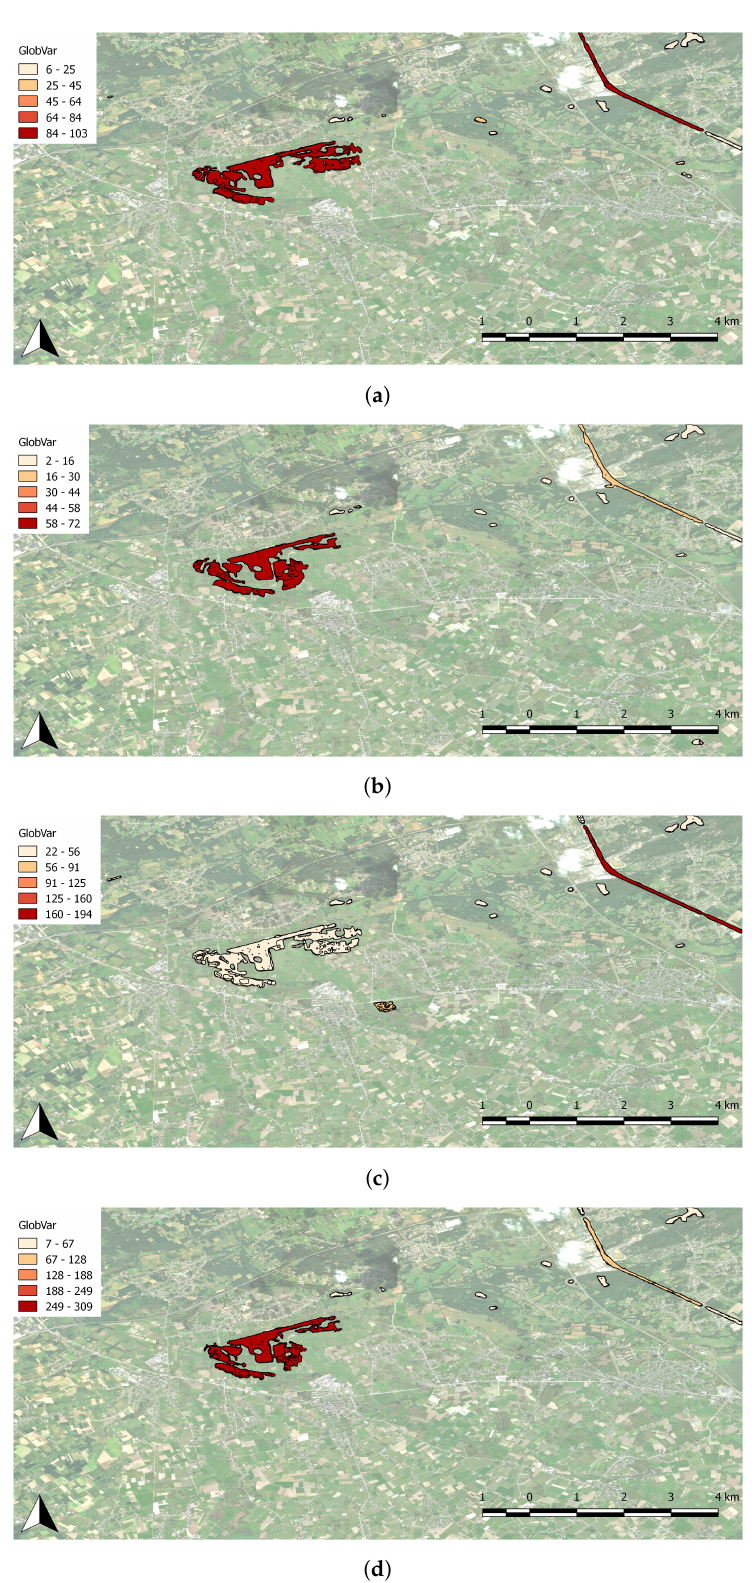
Figure 9. Global variation for permanent entities. ( a ) Ascending time series VV polarisation. ( b ) Ascending time series VH polarisation. ( c ) Descending time series VV polarisation. ( d ) Descending time series VH